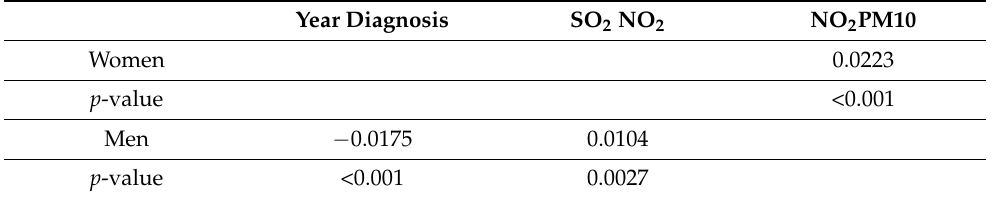
Table 5. Correlation between air pollution and the incidence of squamous cell lung cancer by gender. Year Diagnosis SO 2 NO 2 NO 2 PM10 Women 0.0223 p -value <0.001 Men − 0.0175 0.0104 p -value <0.001